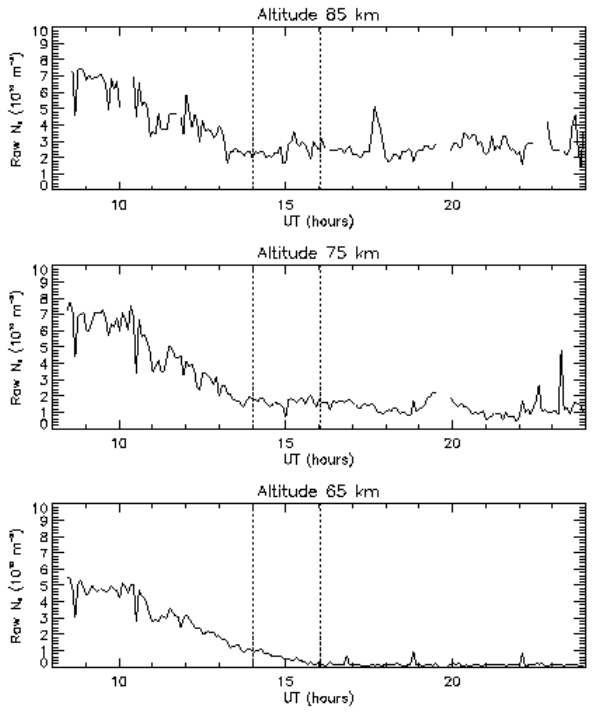
Fig. 5. As Fig. 4 but for 29 October. The radar operated from 08:25 to 08:30